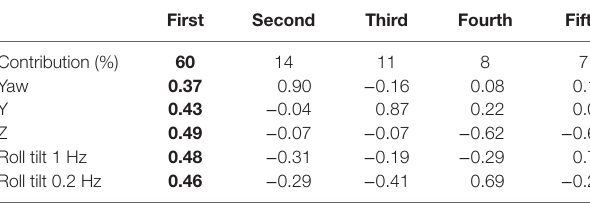
TaBle 3 | Principal component analysis (PCA) of log-transformed thresholds for all subjects.